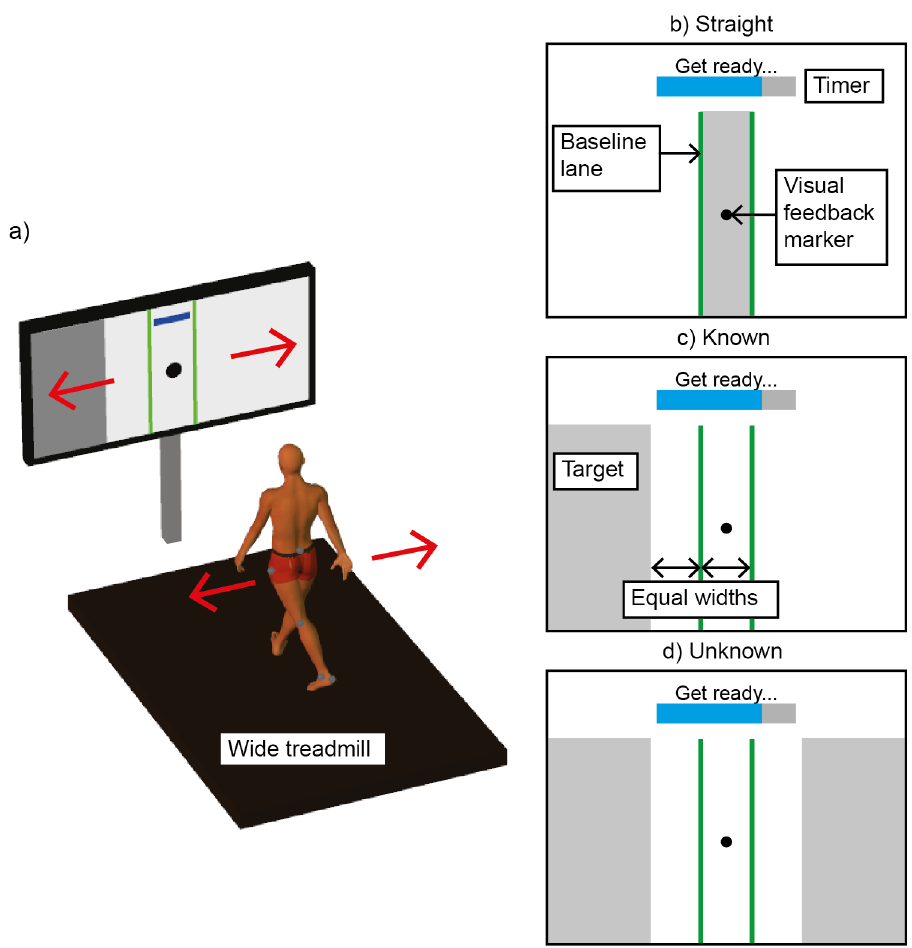
Fig 1. Experimental Setup. a) Subjects ’ lateral movements (red arrows) controlled the lateral position of a real-time Visual Feedback Marker (black sphere). All trials began after subjects positioned the Visual Feedback Marker within the baseline lane shown in green. A progress bar timer then displayed a 5 second countdown and subjects were given visual instructions to “ Get ready ” . When time expired, the on-screen instructions changed to “ GO, ” and subjects maneuvered as quickly as possible to a target lane shown in grey. b) Straight. The target was within the baseline lane. Subjects did not maneuver. c) Known. A target was displayed to the either the left or right of the baseline lane during the 5 second countdown. At “ GO, ” subjects maneuvered to the target. d) Unknown. Targets were displayed simultaneously to both the left and right of the baseline lane. At “ GO, ” one of the targets disappeared, indicating that subjects should maneuver immediately to the remaining